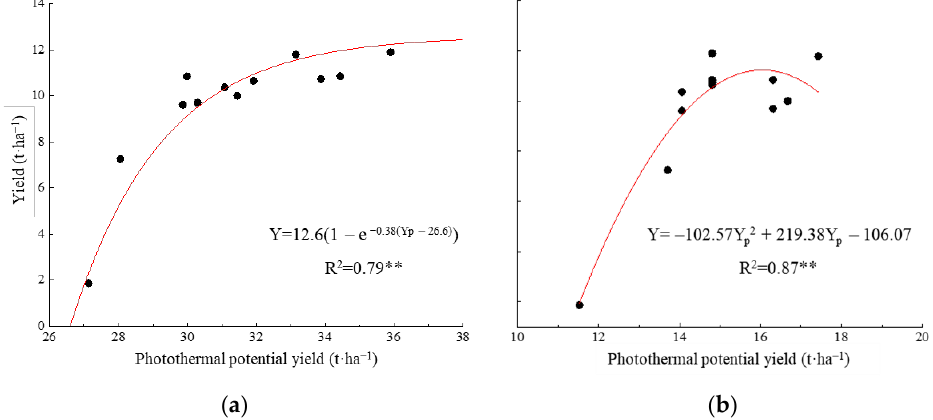
Figure 7. Relationship between winter wheat yield and photothermal potential yield during the WGP ( a ) and the heading–harvesting period ( b ). Note: The red lines represent the fitted regression trend line. The asterisks (**) indicate the trend’s significance at p < 0.01.